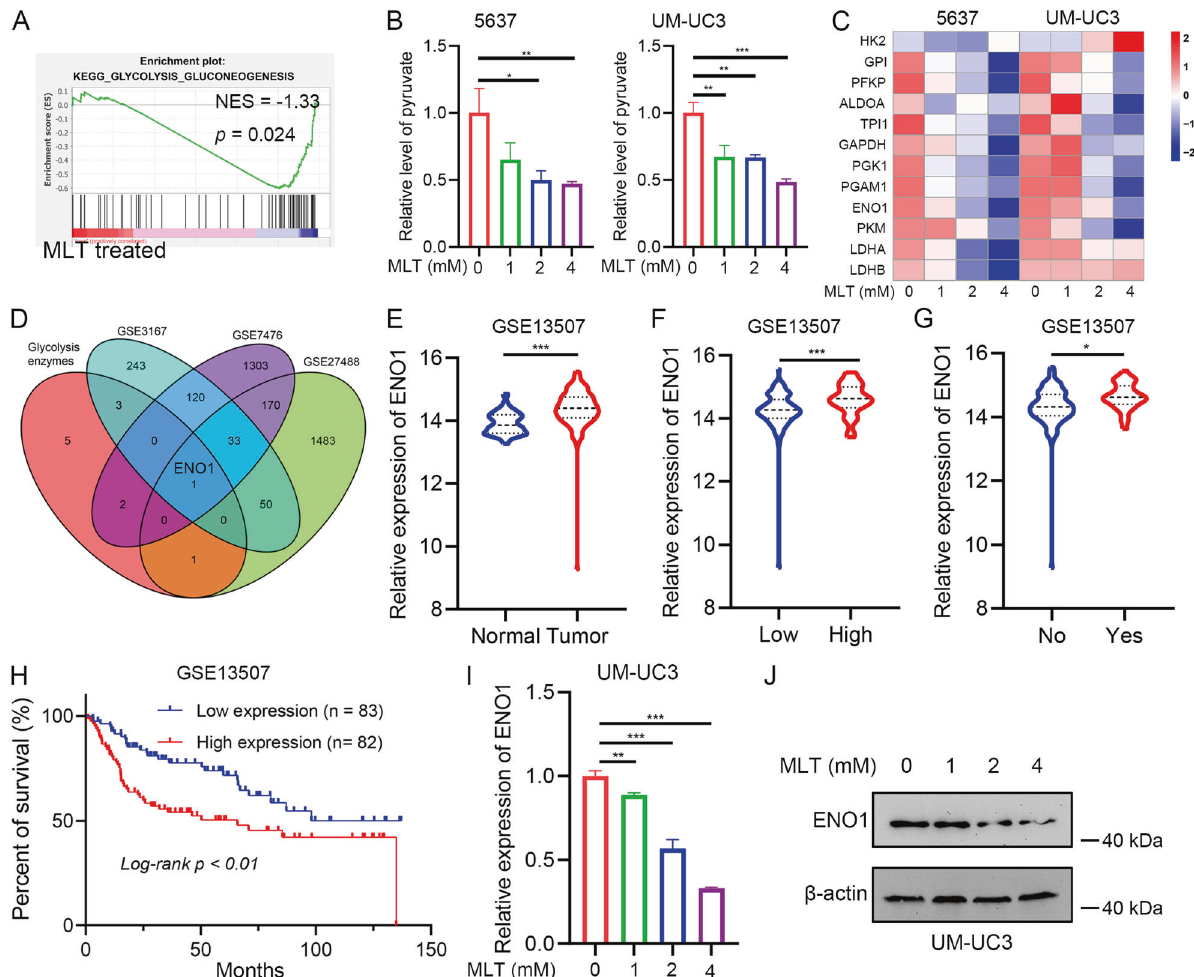
Fig. 2 Identi fi cation of ENO1 as a potential target of melatonin in BLCA cells. A GSEA result of RNA-seq of BLCA cells after 24 h melatonin (0 mM, 1 mM, 2 mM, and 4 mM) treatment. B Detection of cellular pyruvate level after 24 h melatonin treatment in BLCA cells ( n = 3). C Heatmap of the alteration of glycolytic enzymes in BLCA cells after 24 h melatonin (0 mM, 1 mM, 2 mM, and 4 mM) treatment. D Venn map of co-DEGs in GSE3167, GSE7476, GSE27488, and glycolysis enzymes. E Expression level of ENO1 in normal bladder tissues versus BLCA tissues in GSE13507 dataset. F Expression level of ENO1 in low-grade BLCA tissues versus high-grade BLCA tissues in GSE13507 dataset. G Expression level of ENO1 in BLCA tissues with or without progression in GSE13507 dataset. H Survival analysis of BLCA patients with different ENO1 mRNA level in GSE13507 dataset. I qRT-PCR analysis of ENO1 expression alteration after 24 h melatonin (0 mM, 1 mM, 2 mM, and 4 mM) treatment in BLCA cells ( n = 4). J Western blot assay of ENO1 protein alteration after 24 h melatonin (0 mM, 1 mM, 2 mM, and 4 mM) treatment in BLCA cells. * p < 0.05, ** p < 0.01, *** p <